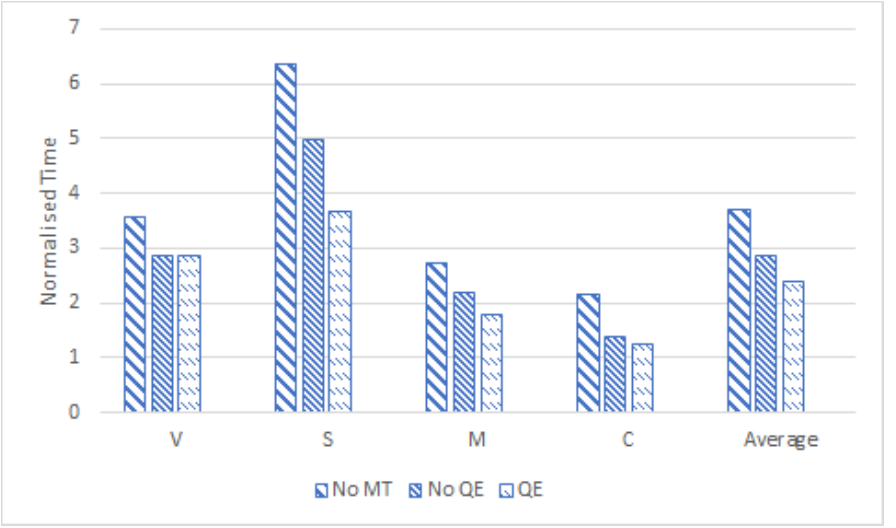
Figure 3. Normalised Number of seconds per word spent translating/post-editing.